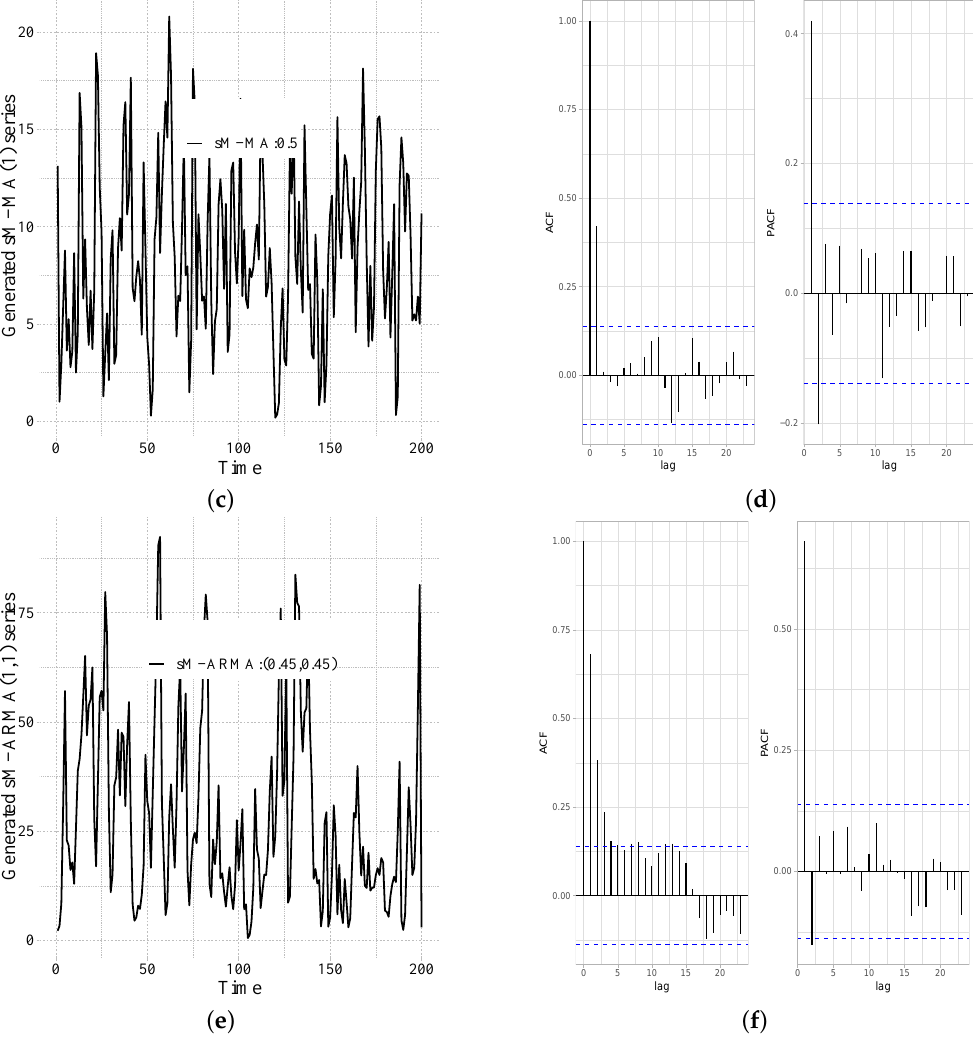
Figure 2. Generated series from the sMuth–ARMA and its pairs (ACF, PACF). ( a ) For